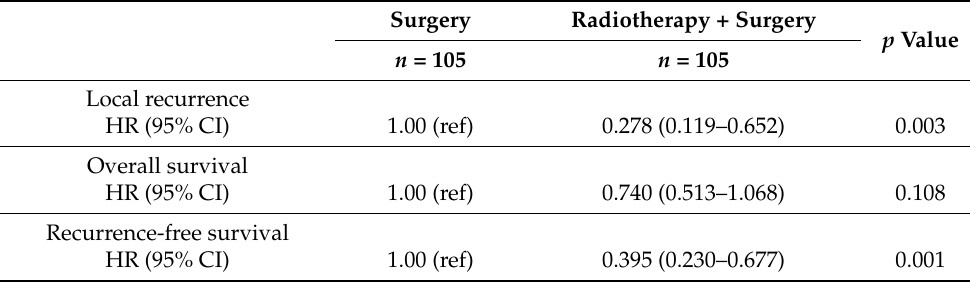
Table 3. Oncological outcomes in analyzed groups (R0), comparison at the end of follow-up. Surgery Radiotherapy +